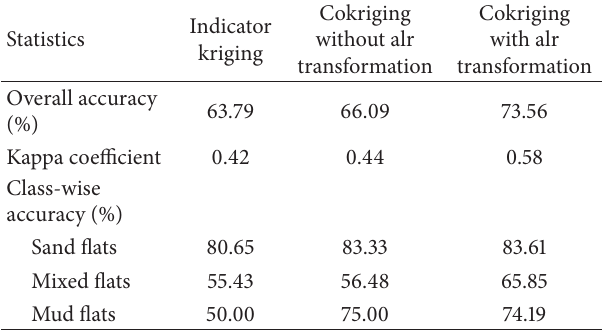
Table 6: Mapping accuracy statistics by different mapping algo-